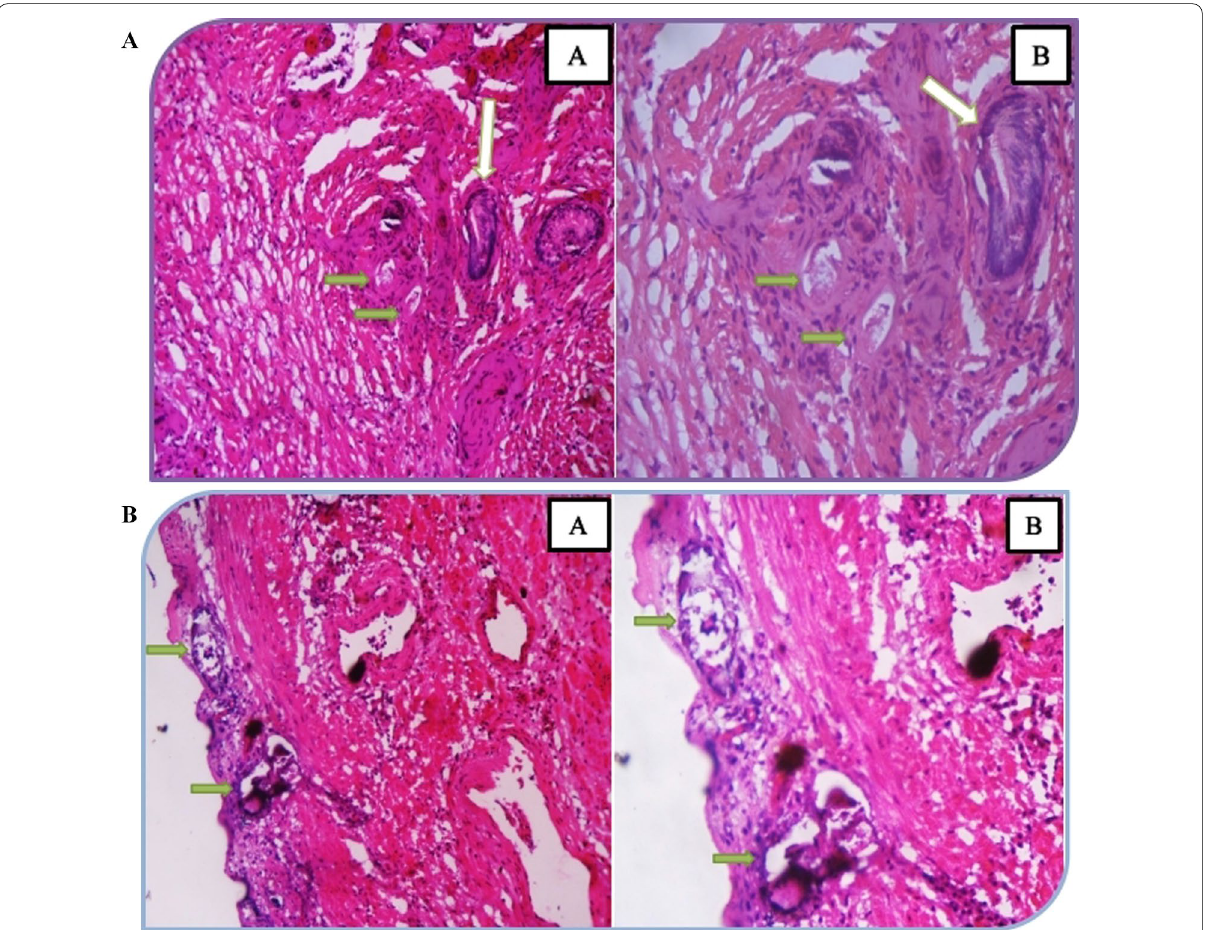
Fig. 1 a Nodular hyperplasia of the prostate with Schistosoma ova (green arrow) in myofibrous stroma. The white arrow is a benign gland. a H & E X 200 while b H & E X 400. b Nodular hyperplasia of the prostate with schistosoma ova (green arrow) in myofibrous stroma. a . H & E X 200 while b